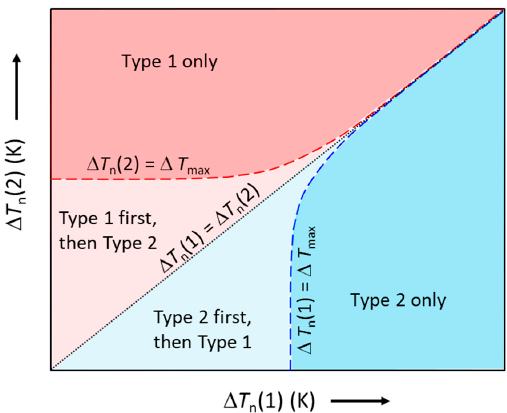
Figure 8. Schematic illustration of the competition for nucleation between two types of particles (Type 1 and Type 2). The red and blue dashed lines represent ∆ T n (2) = ∆ T max and ∆ T n (1) = ∆ T max , respectively; the black dotted line represents ∆ T n (1) = ∆ T n (2). In the red area, only Type 1 particles nucleate; in the blue area, only Type 2 particles nucleate; in the light red area, Type 1 particles nucleate first, followed by Type 2 particles; in the light blue area, Type 2 particles nucleate first, followed by Type 1 particles.